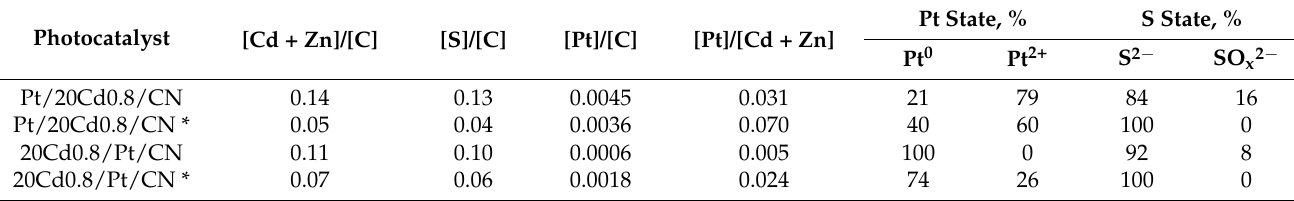
Table 3. Surface properties of the photocatalysts Pt/20Cd0.8/CN and 20Cd0.8/Pt/CN before and after the photocatalytic hydrogen production based on XPS